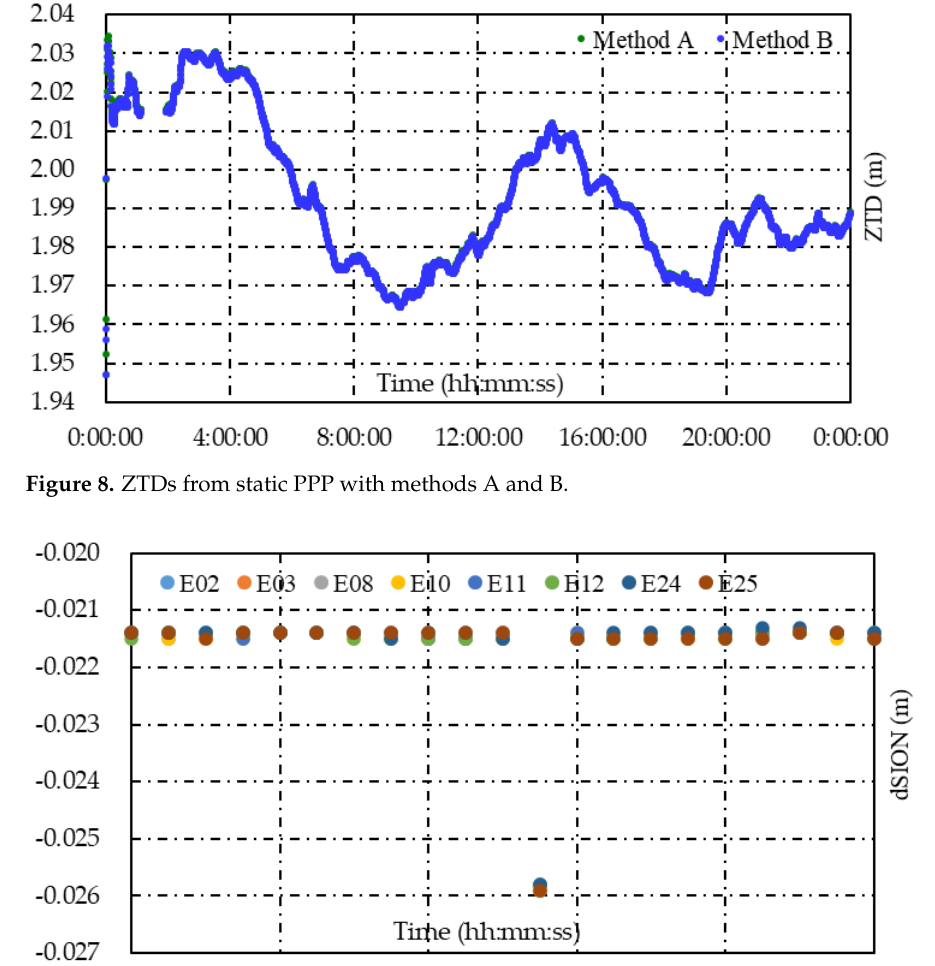
Figure 8. ZTDs from static PPP with methods A and B.